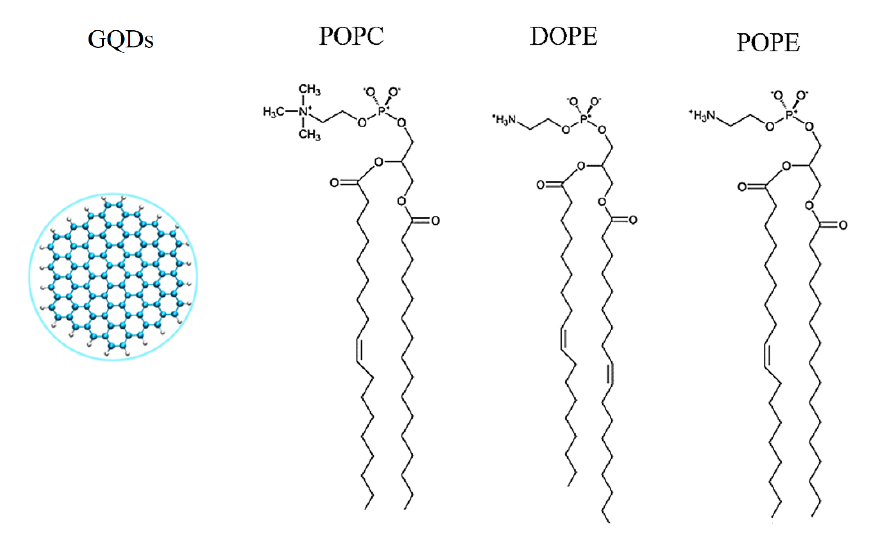
Figure 1. Structural details of three phospholipids and GQDs. Table 1. Simulation details of the phospholipid molecules.